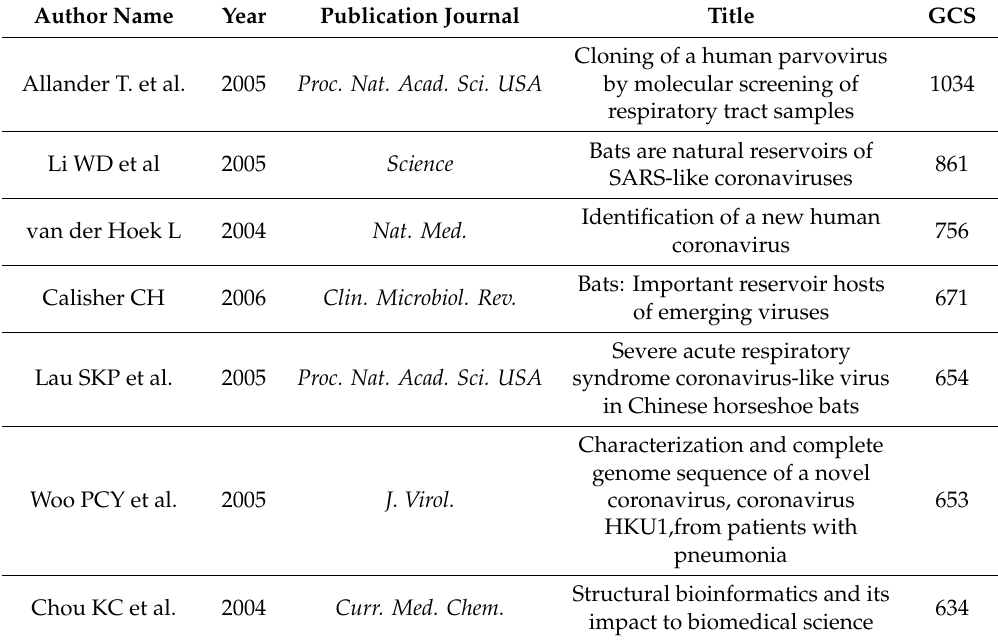
Table 4. Top cited papers during